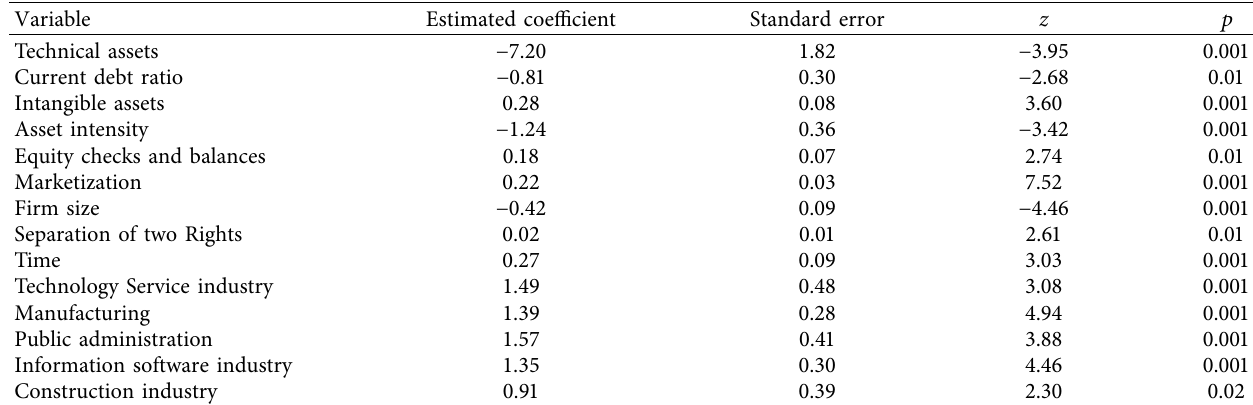
Table 3: Variable screening